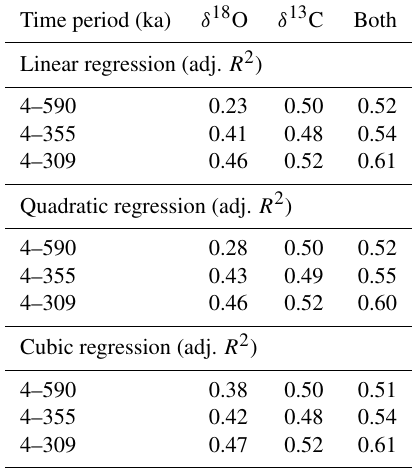
Table 3. Adjusted R 2 values for different models with various re- gression analysis methods.